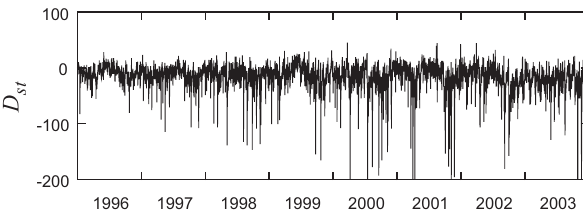
Fig. 1. Time series of daily values of the D st index from 1996 to